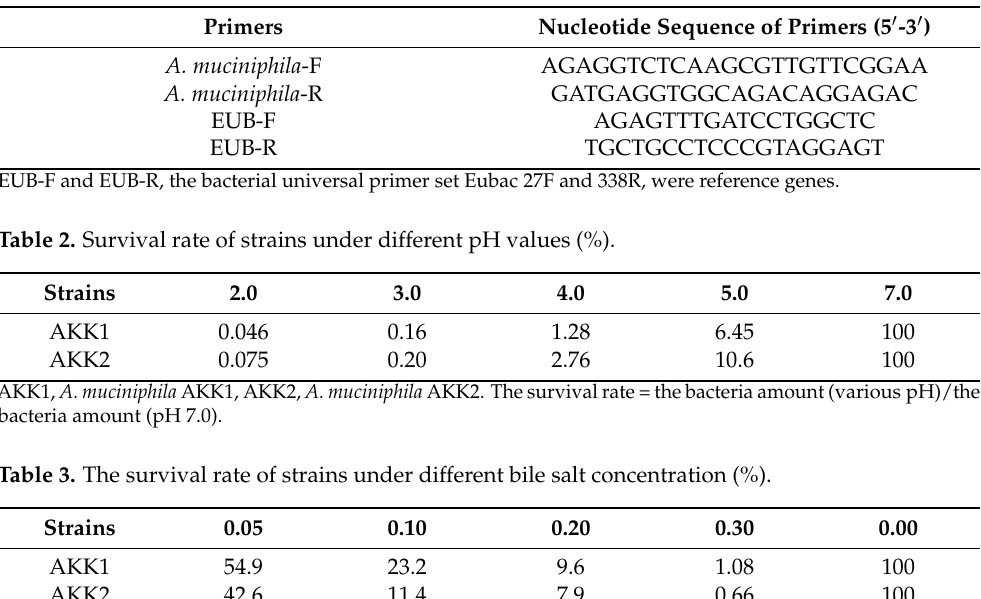
Table 1. The primer sequences for RT-PCR.